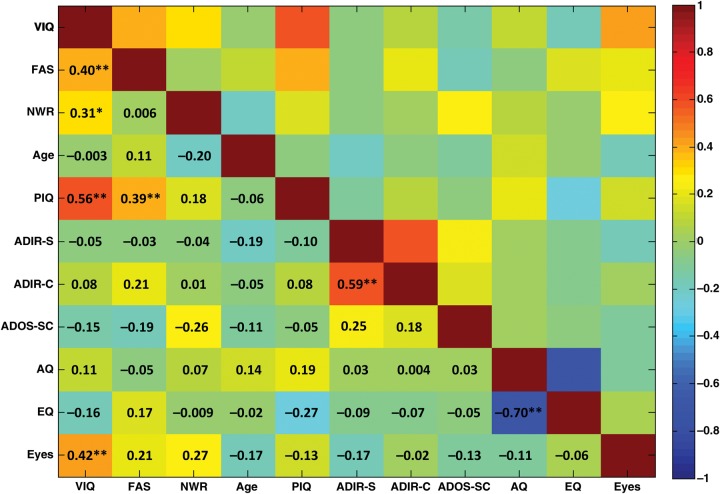
Current structural language abilities and behavioral characteristics. This correlation matrix shows the pair-wise Pearson's correlations among current language measures and demographic/behavioral characteristics. Color-coding indicates the strength of the correlation, and each cell gives the Pearson's r. *P < 0.01, **P < 0.001.